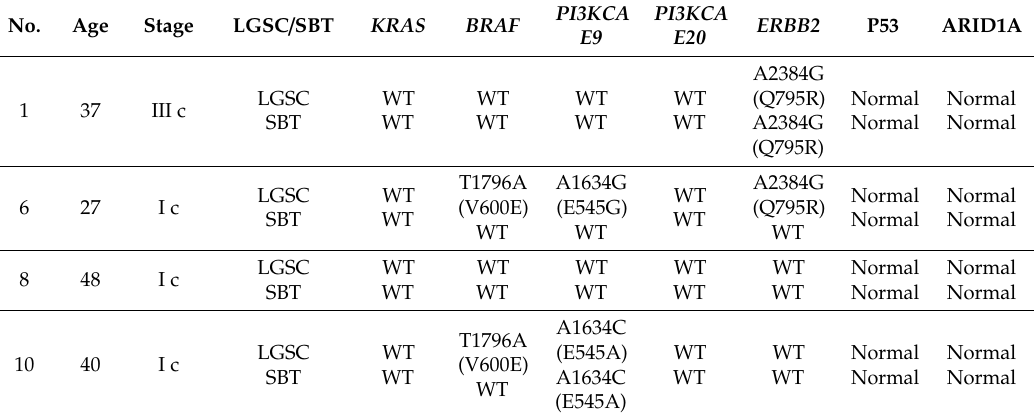
Figure 3. Synchronous LGSCs and SBTs with matched PIK3CA and BRAF sequences in an LGSC case. ( A ) LGSC showing mutations E545K (1633 G > A), in PIK3CA , and V600E (1796T > A), in BRAF . ( B ) SBT showing a mutation, E545K (1633 G > A), in PIK3CA , and wild-type BRAF. Scale bar =200µm. C; cytosine, T; thymine, G; guanine, A; adenine. Table 4. Mutation and immunohihistochemical analysis in four cases of LSGC accompanied by SBT. WT; Wild Type.